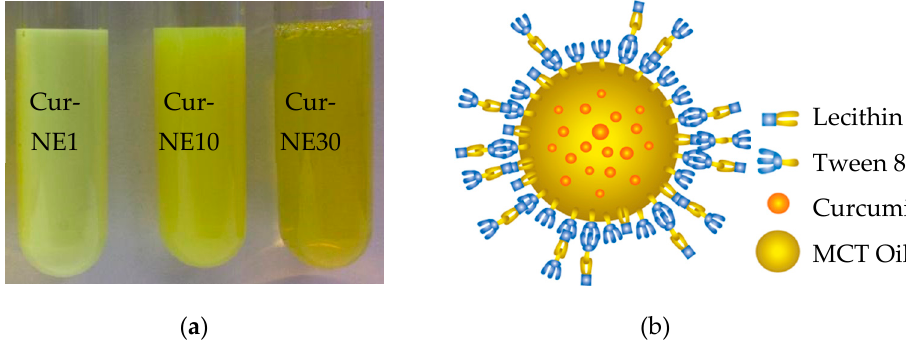
Figure 1. Nanoemulsions formed at three concentrations of surfactant depicted as Cur-NE1, Cur-NE10, and Cur-NE30 ( a ) and schematic structure of curcumin nanoemulsion ( b ). Table 1. Compositions and characteristics of Curcumin nanoemulsions (Cur-NEs).